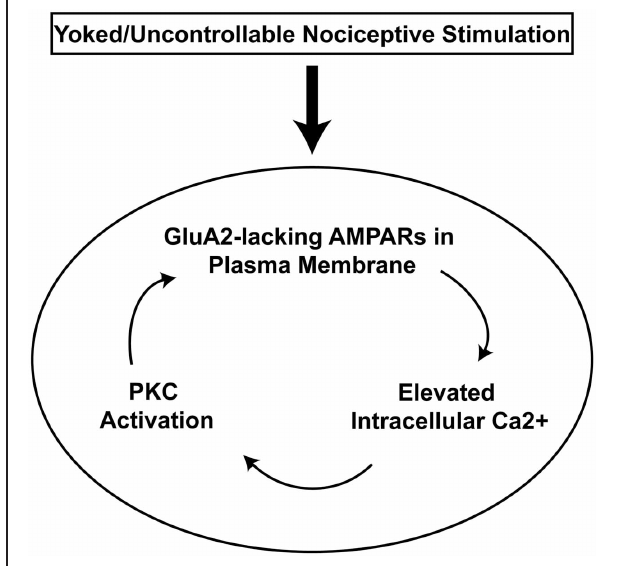
FIGURE 6 | AMPA receptor positive feedback-loop hypothesis for spinal metaplasticity. Spinal AMPARs are hypothesized to rapidly traffic to the plasma membrane in response to uncontrollable nociceptive stimulation in the periphery (box). Because GluA2-lacking AMPARs function as calcium ionophores, their localization to the membrane generates a cascade of increased intracellular calcium followed by activation of intracellular calcium detectors such as PKC that can then produce further increases in trafficking of AMPARs to the plasma membrane. This feedback loop (oval) of increasing AMPA receptor numbers may account for the observed pattern of saturation of spinal learning plasticity, spinal learning deficits, and nociceptive hyper-responsiveness that is observed after yoked/uncontrollable stimulation